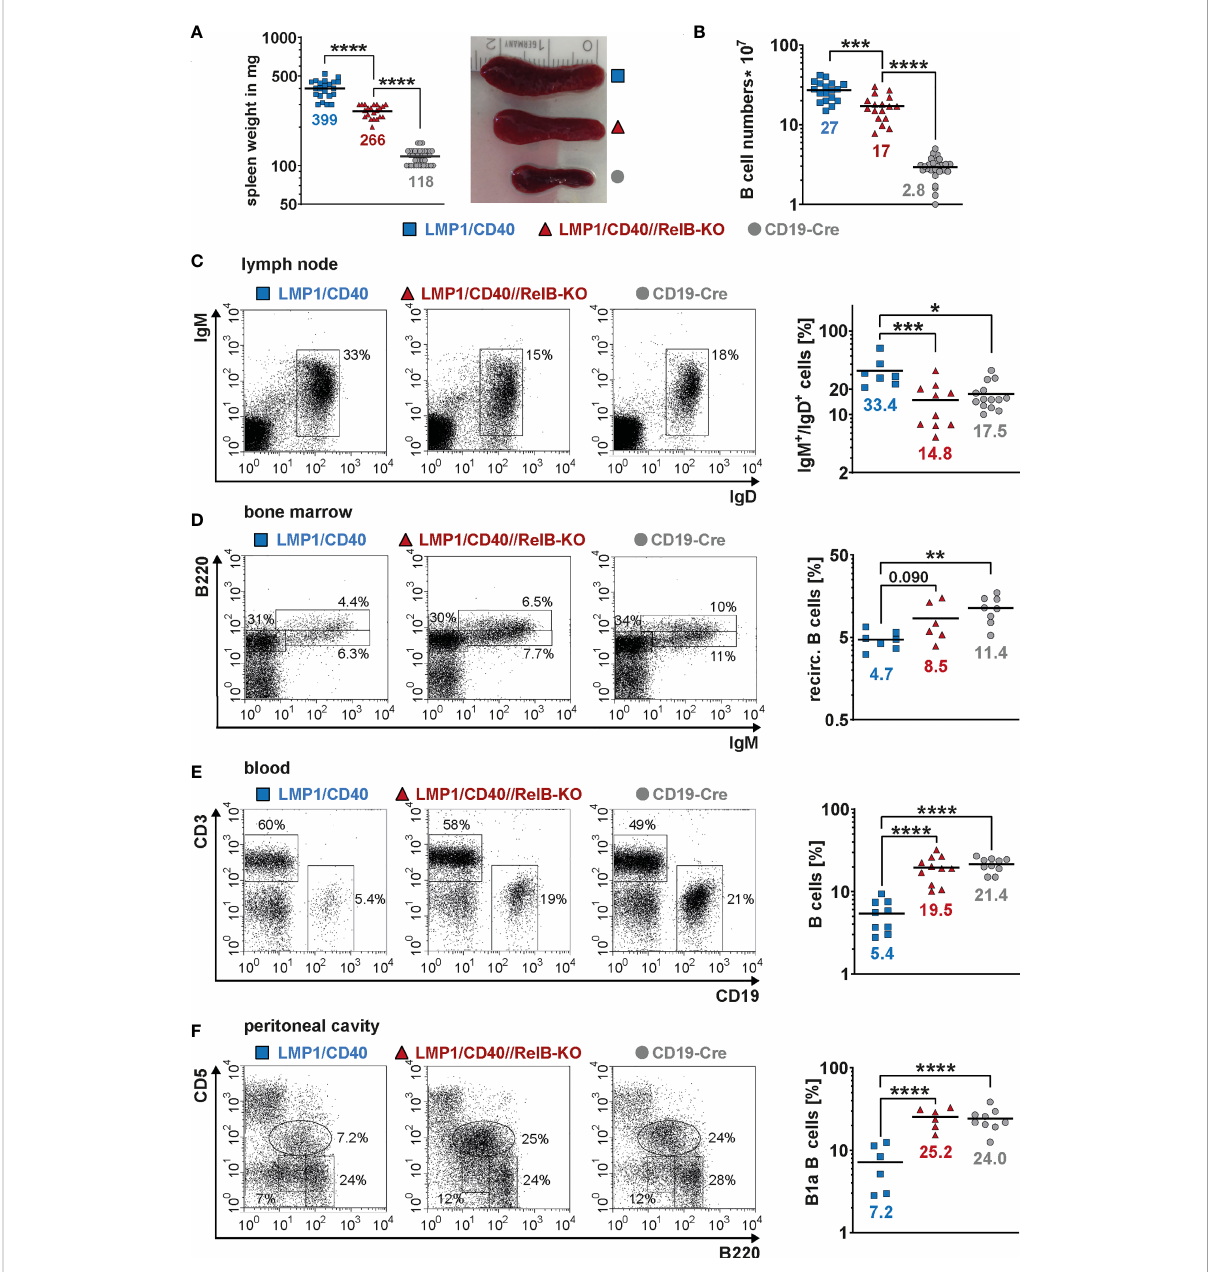
FIGURE 2 Inactivation of RelB in LMP1/CD40 mice leads to reduced B cell numbers in secondary lymphoid organs: (A) Splenic weight and size of the indicated genotypes. N ≥ 21. (B) Splenic B cell numbers in the indicated genotypes. N ≥ 17. (C) Percentages of IgM + IgD + B cells in inguinal lymphnodes. FACS plots are pre-gated on live lymphocytes. LMP1/CD40 N =7; LMP1/CD40//RelB-KO N =10; CD19-Cre N =14. (D) Percentages of recirculating B cells in the BM. FACS plots are pre-gated on live lymphocytes. Recirculating B cells were determined as IgM + B220 high . LMP1/ CD40 N =7; LMP1/CD40//RelB-KO N =6; CD19-Cre N =8. (E) Percentages of B cells (CD19 + ) and T cells (CD3 + ) in the blood. Plots are pre-gated on live lymphocytes. The graph compiles the percentages of CD19 + B cells from different independent experiments. LMP1/CD40 N =9; LMP1/ CD40//RelB-KO N =11; CD19-Cre N =10. (F) Percentages of B1a (B220 low CD5 + ) and B2 (B220 + CD5 − ) cells in the peritoneal lavage. FACS plots are pre-gated on live lymphocytes. The graph compiles the percentages of B1a cells. LMP1/CD40 N =6; LMP1/CD40//RelB-KO N =6; CD19-Cre N =9. (A – F) Due to their lognormal distribution values were logarithmized before statistical analysis with an ordinary one-way ANOVA, Tukey´s multiple comparisons test with * P<0.05, ** P<0.01, *** P<0.001, **** P<0.0001. (A – F) Symbols represent values from individual mice, and the lines and numbers indicate the